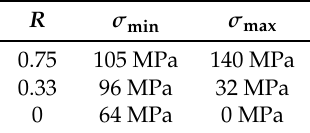
Table 7. Loading information for the a-N curves.